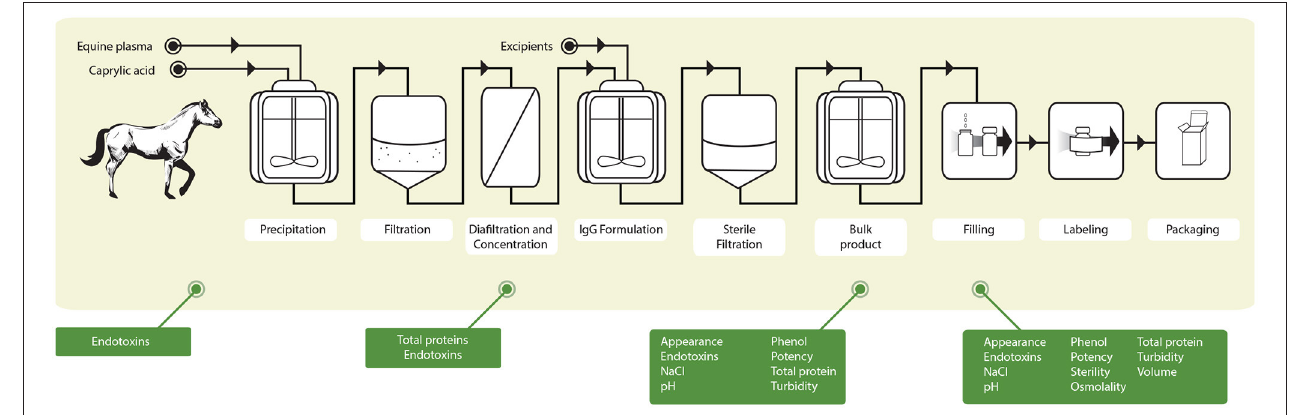
FIGURE 1 | Schematic summary of the protocol followed for the production of the anti-SARS-CoV-2 ICP at the Clodomiro Picado Institute in Costa Rica. Groups of horses were immunized with either the S1 viral protein or a mixture of S1, N and SEM viral proteins. After immunization, horses were bled, and the plasma was separated and fractionated according to the scheme shown. The green boxes depict the quality control assays carried out during the process of fractionation and of the final product. In addition, ELISA antibody titers against viral proteins and neutralization of virus infectivity in cell culture were done by plaque reduction neutralization tests to ensure viral neutralization efficacy [see Leon et al. ( 37) for